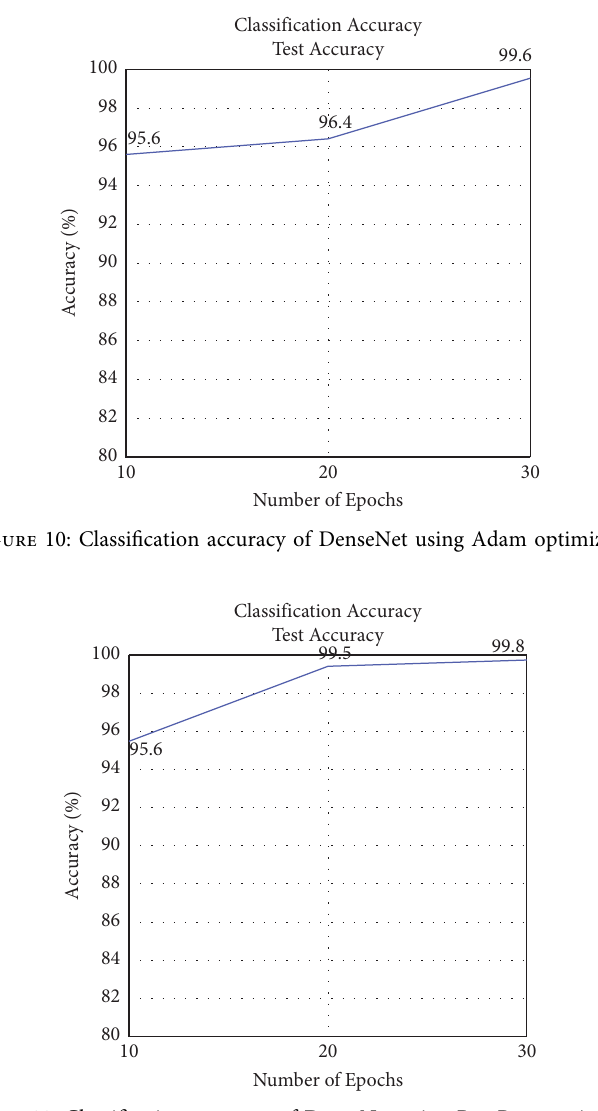
Figure 11: Classifcation accuracy of DenseNet using RmsProp optimizer.